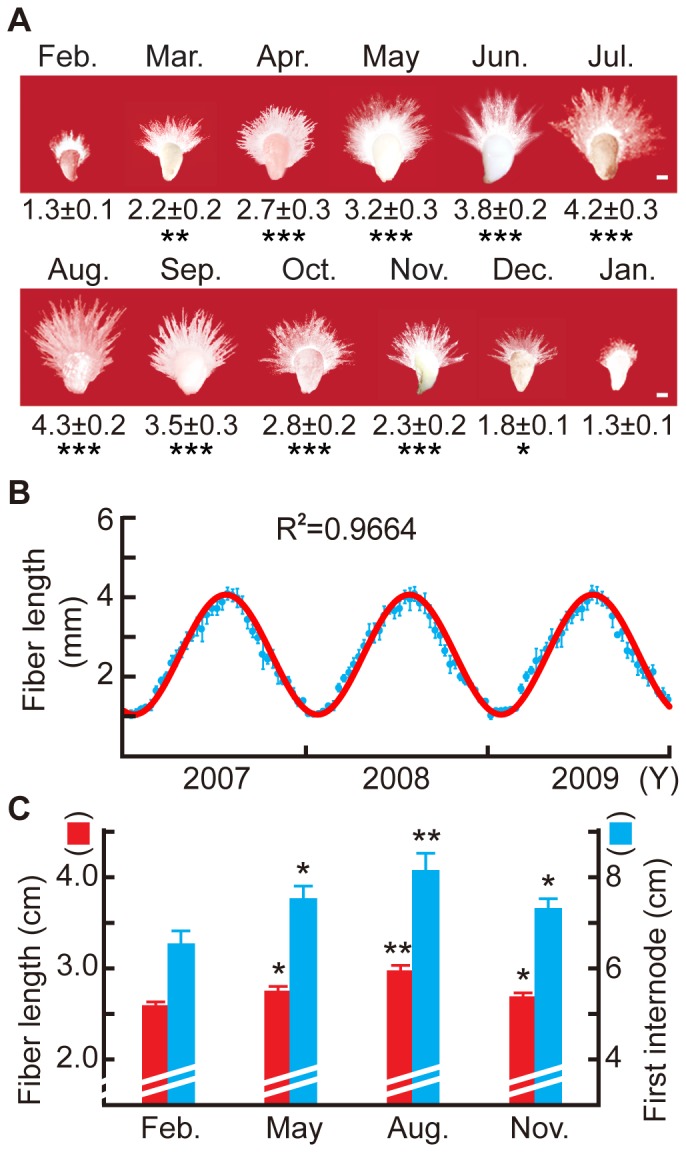
Annual growth potential change of cotton plants.(A) Cotton ovule growth potential as a function of month in which ovules were harvested. Ovules were harvested 1 dpa during the month indicated, cultured for 6 d, and measured for fiber length. Numbers indicate fiber length (mean ± SE, in mm). Each ovule in this panel is a representative of thirty in the same culture. (B) Growth of cotton fibers from ovules harvested over the same monthly cycle for three consecutive years. (C) Cotton fiber length and first main stem internode length in planta in four different seasons. Error bars, SE. In (A–C), n = 6; In (A,C), *p<0.05, **p<0.01, ***p<0.001.